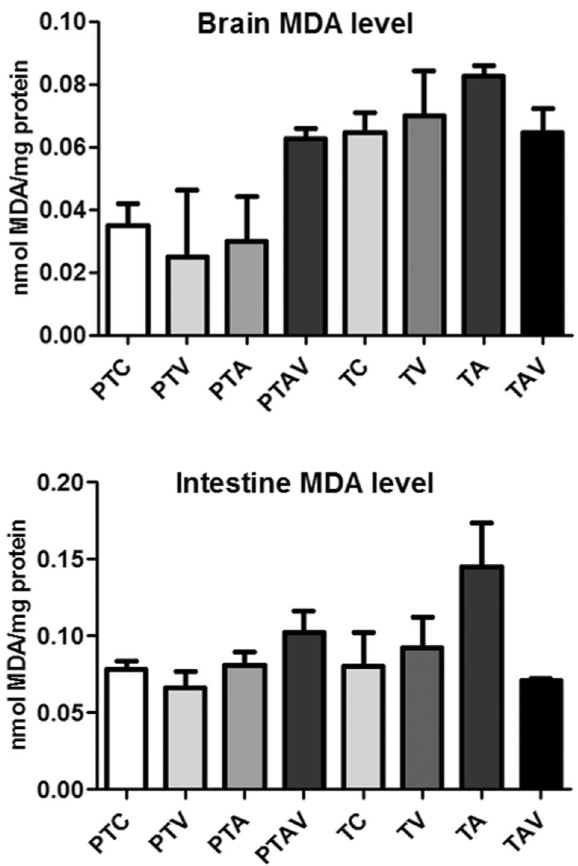
Figure 6. Brain and intestine malondialdehyde (MDA) levels in newborn rats. PTC: preterm control; PTV: preterm ventilated; PTA: preterm asphyxiated; PTAV: preterm asphyxiated and venti- lated; TC: term control; TV: term ventilated; TA: term asphyxiated; TAV: term asphyxiated and